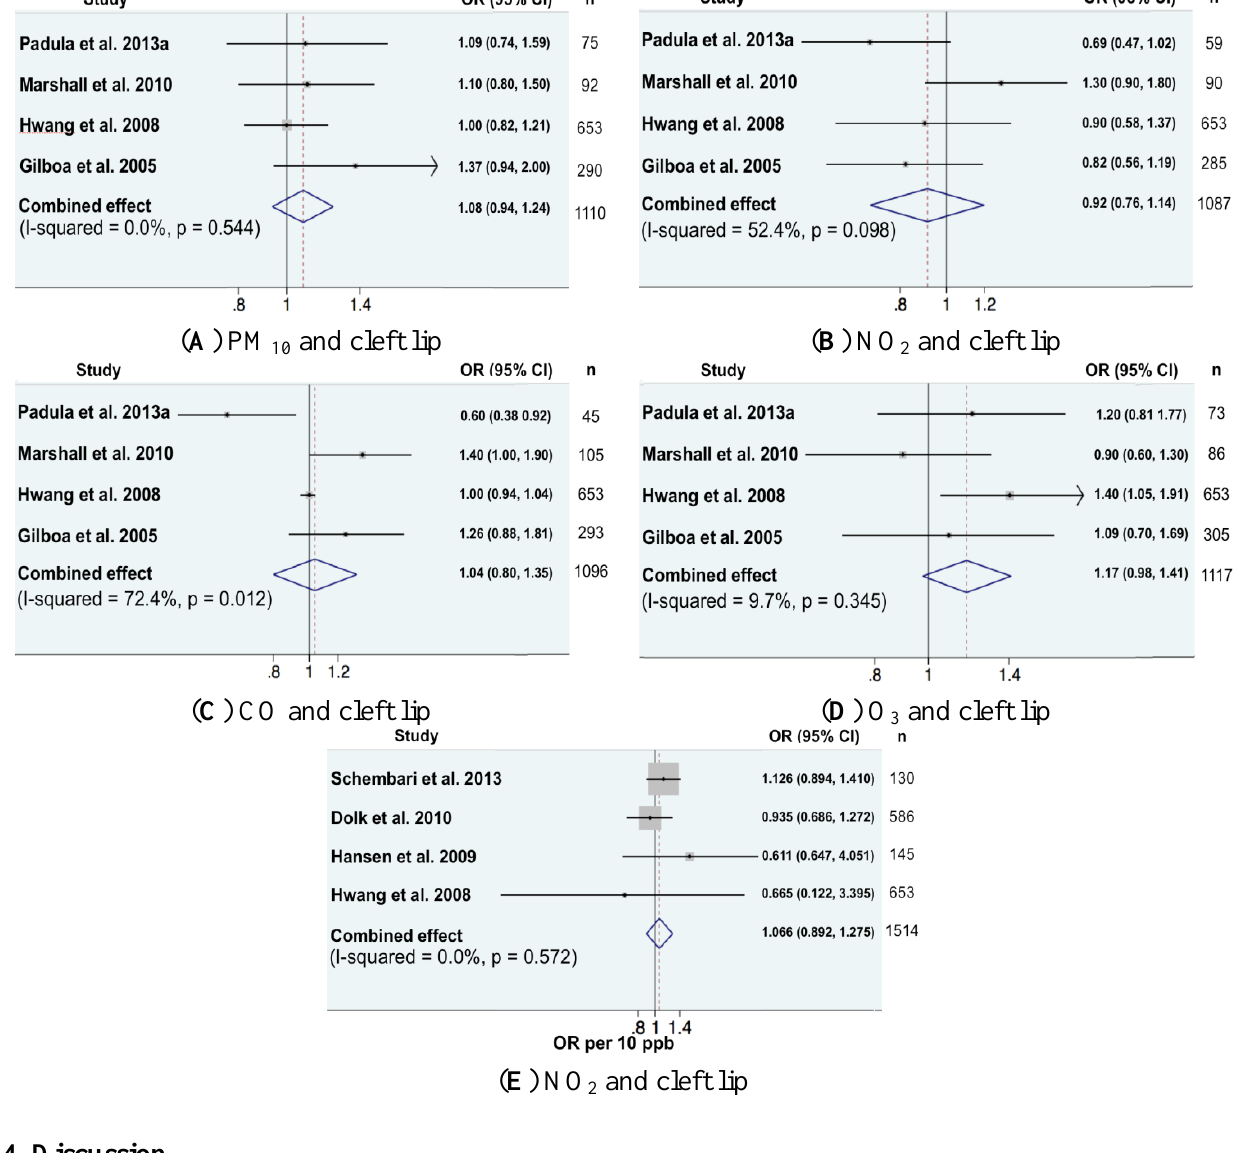
Figure 4. Forest plots for a variety of pollutants and risk of orofacial defects. ( A ), ( B ), ( C ) and ( D ) showed combined effects of PM of NO and cleft lip from continuous exposure risk 2